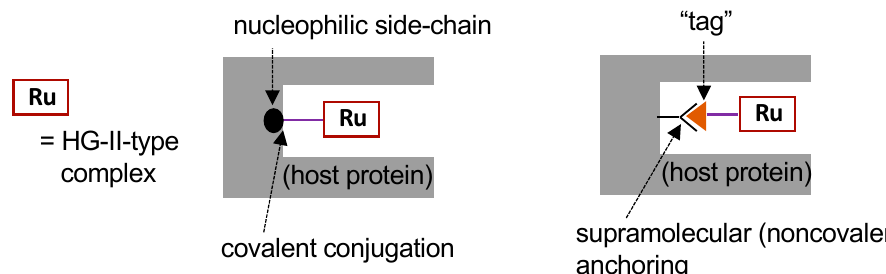
Figure 3. Strategies for the construction of artificial metalloenzymes with olefin metathesis activity (OM-ArMs) [17].